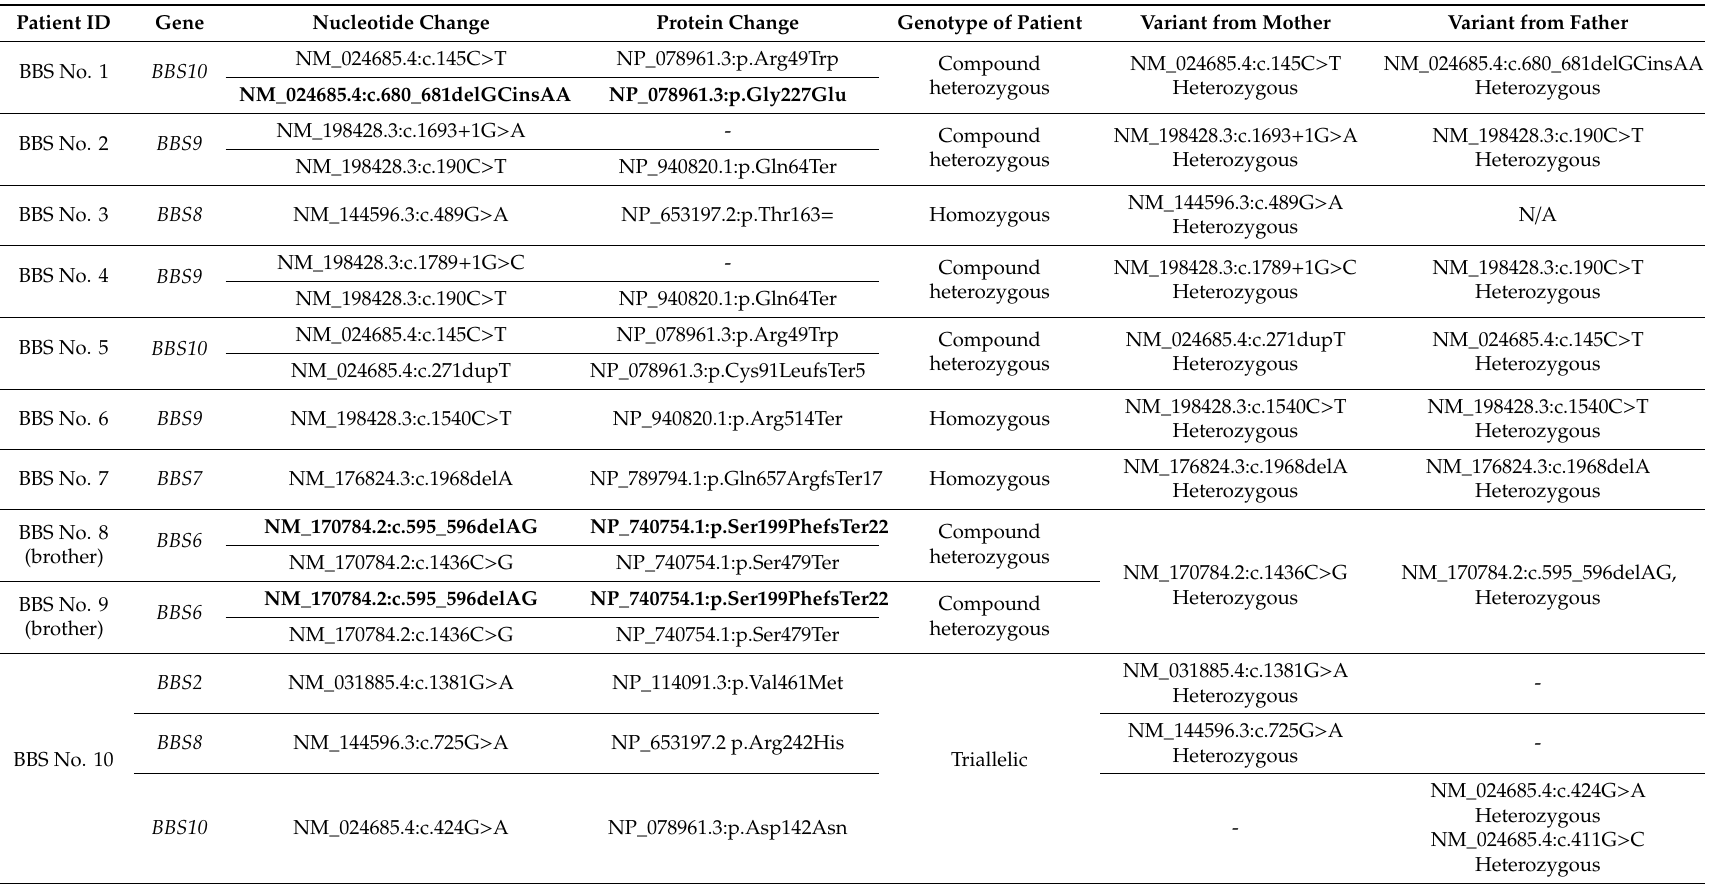
Table 2. Summary of variants detected in Polish Bardet–Biedl syndrome